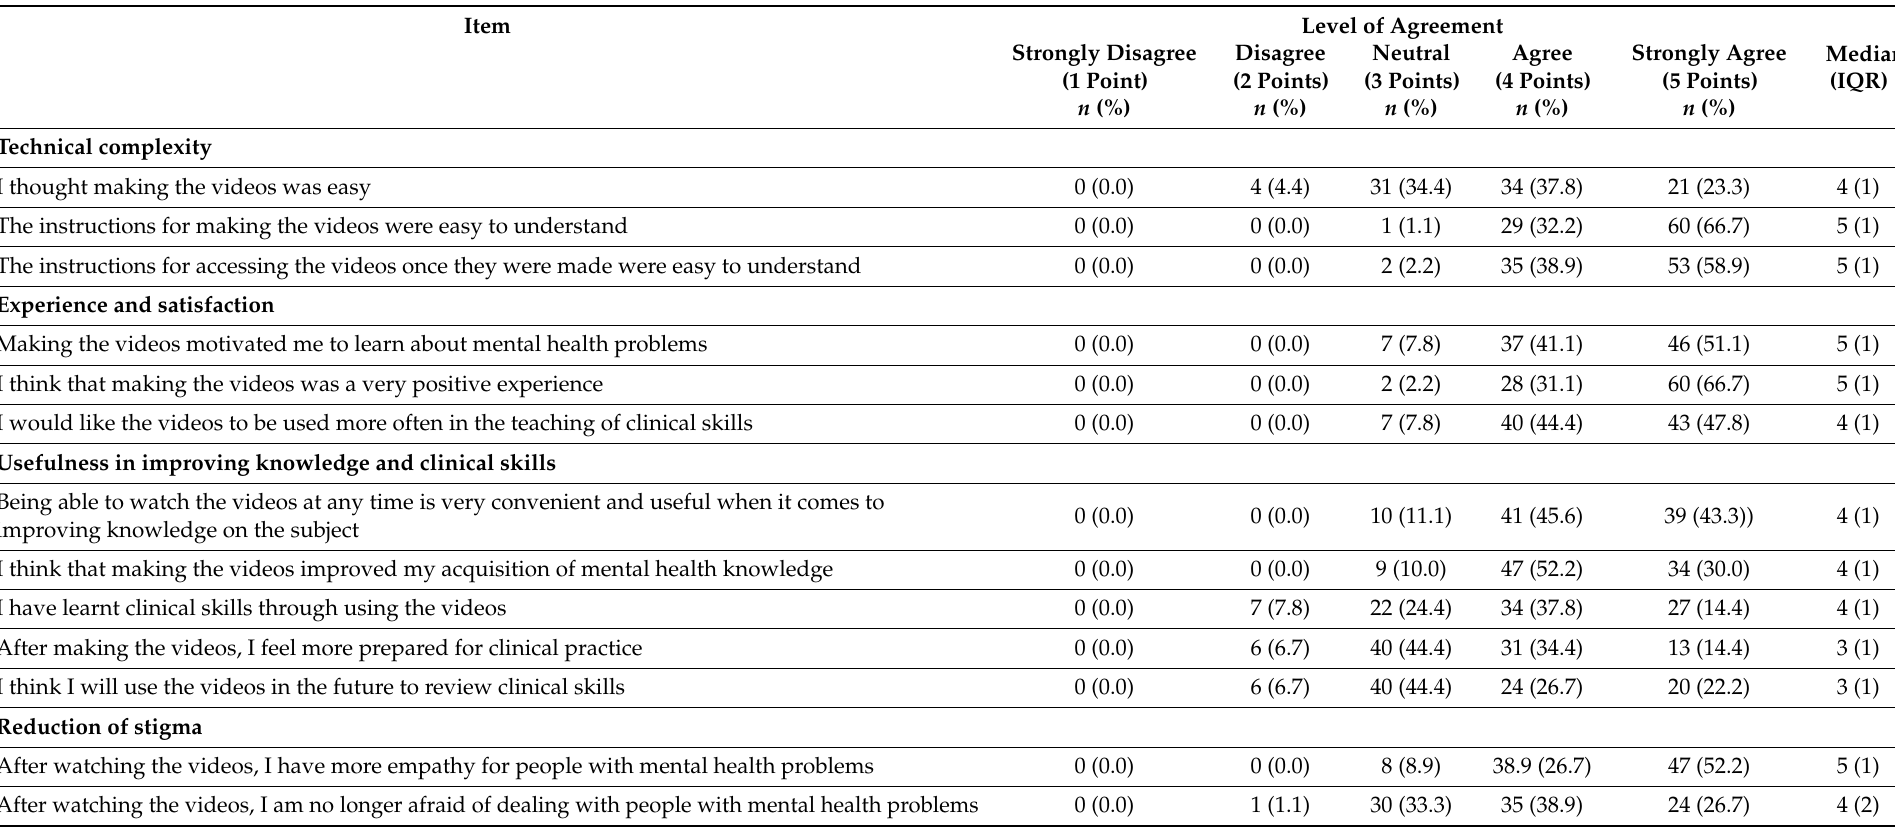
Table 1. Student assessment of the training